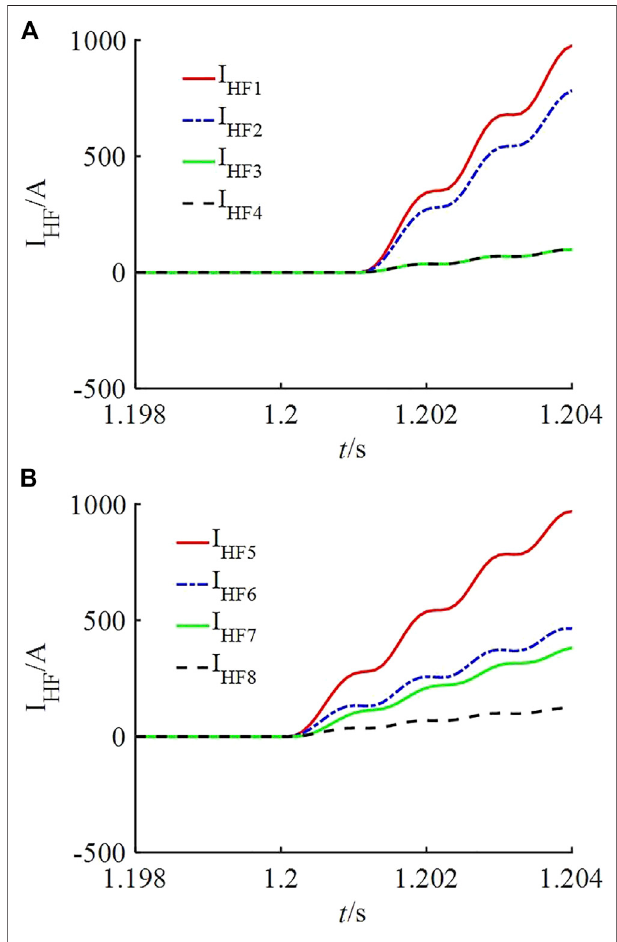
FIGURE 12 | High-frequency current amplitude waveforms under an external fault without data synchronization (A) PZ I (B) PZ II.